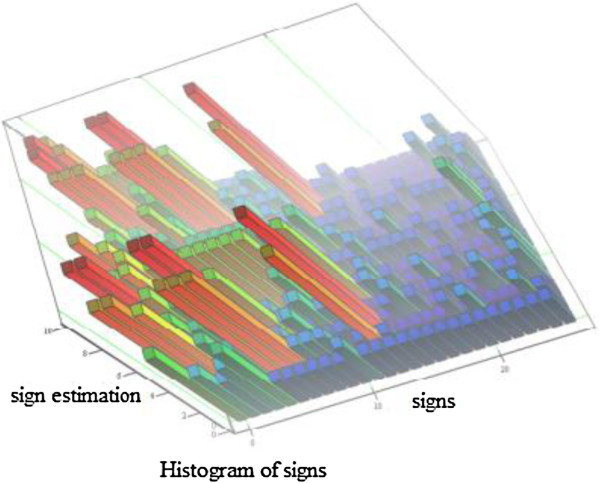
Ranking histogram.